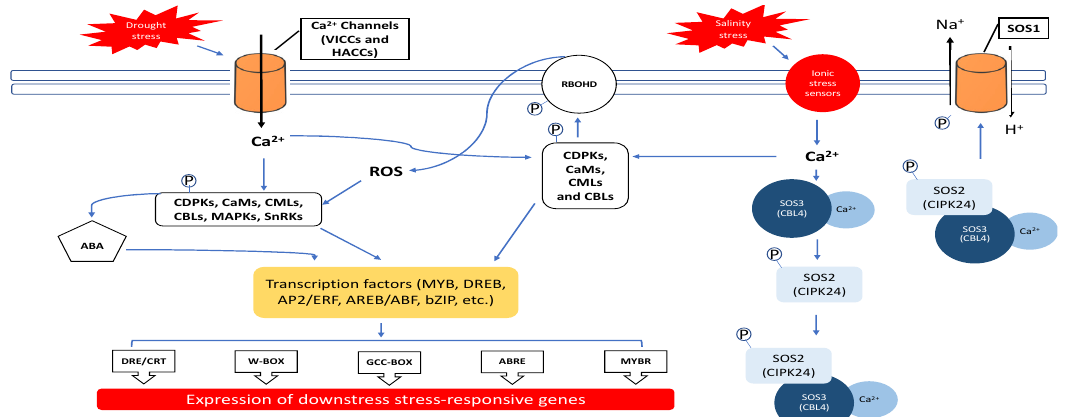
Figure 1. Generic pathway for plant response to salinity and drought stresses in Arabidopsis thaliana cell. Salinity and drought elicit Ca 2+ signals through the SOS pathway to achieve ionic homeostasis. When the ions are increased, it is first perceived by the ionic stress sensors, and then the Ca 2+ levels are increased. The Ca 2+ binds to the SOS3 protein and then interacts with the SOS2 protein kinase. The Ca 2+ –SOS3–SOS2 complex phosphorylates and activates the SOS1 membrane protein, which will cope with the ionic stress. This change in cytoplasmic Ca 2+ level is sensed by calcium sensors (CDPKs, CaMs, CMLs and CBLs) that interact with their downstream signaling components, which could be RBOHD or transcription factors. The activation of RBOHD leads to the generation of ROS molecules, which in turn aid in the signaling mechanism through the interaction with many molecules such as phytohormones or several kinases. Those phytohormones (ABA) or the protein kinases interact with the stress-inducible TFs. Those stress-inducible TFs carry specific DNA-binding domains that bind to specific regulatory sequences found upstream of the stress-inducible gene and initiate transcription. Those genes will lead to several physiological and chemical changes that would enhance the plant's tolerance to salinity and drought stresses.